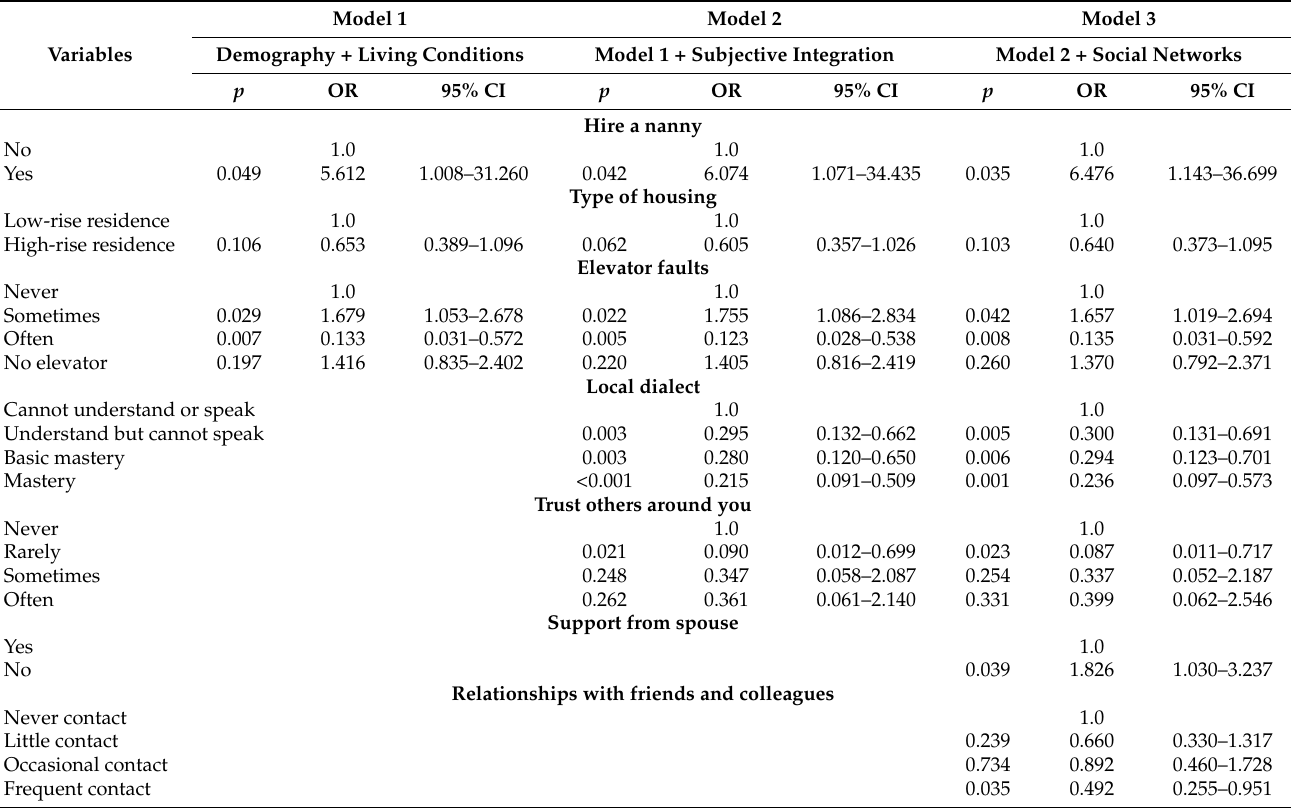
Table 2. Binary logistic regression for relationships between related variables and MCS of